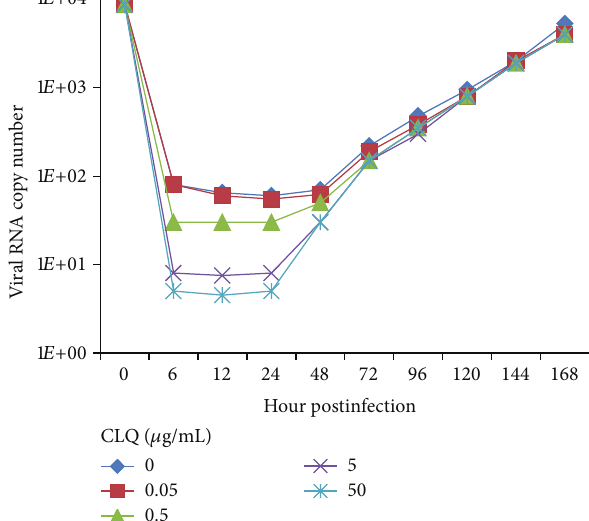
Figure 4: Action of chloroquine on DENV-2 replication in Vero cells. The viral RNA present in the culture supernatants of Vero cells infected with DENV-2, both untreated and treated with chloroquine just after infection, was extracted and analyzed by qRT-PCR. The results represent the average values of the number of copies of viral RNA ( 𝑃 < 0.001